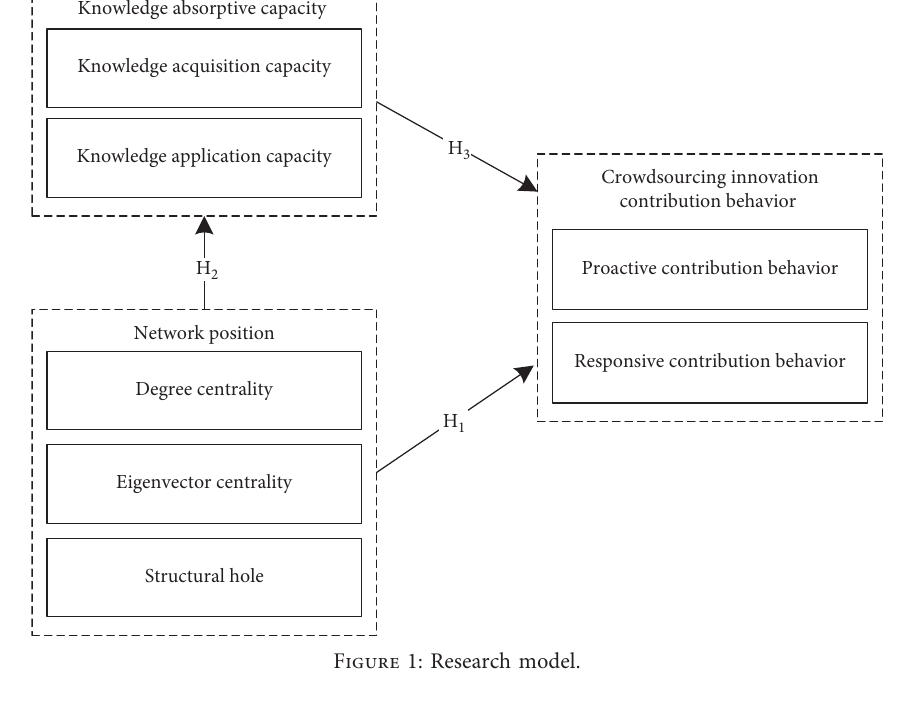
Figure 1: Research model.